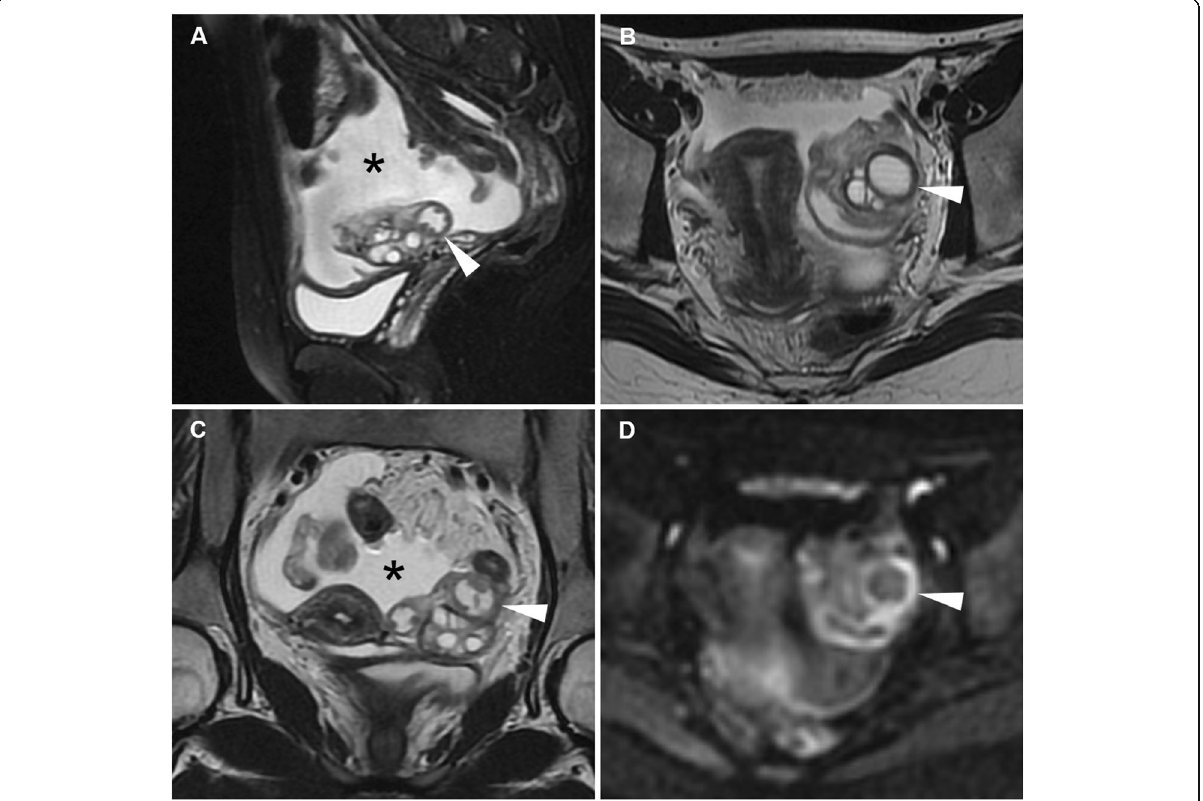
Fig. 12 Acute salpingitis in a 25-year-old woman with pelvic pain and mild neutrophilic leukocytosis. Sagittal fat-suppressed ( a ), oblique-coronal ( b ) and oblique-axial ( c ) T2-weighted images show slightly dilated left fallopian tube with thickened walls (arrowheads). On axial diffusion- weighted imaging (DWI, b = 800 s/mm 2 ) image ( d ), the tubal wall thickening demonstrates restricted diffusion (arrowheads), finding consistent with acute inflammation. Note pelvic peritoneal effusion